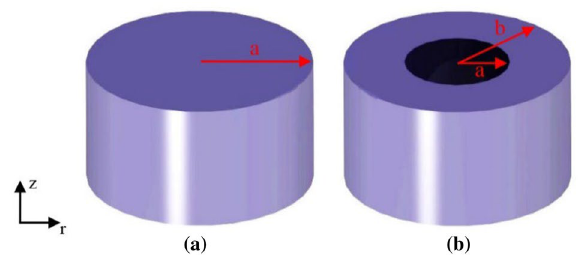
Fig. 2 a Solid and b hollow